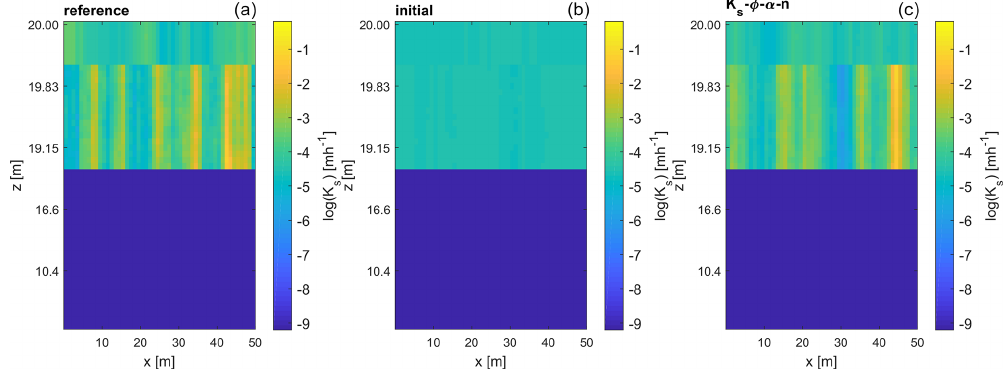
Figure 14. Vertical cut of the saturated hydraulic conductivity field at y = 25m for the reference run, the initial ensemble, and the estimated field when updating all parameters. The z axis is scaled for better visibility. Note that panels (b) and (c) are ensemble